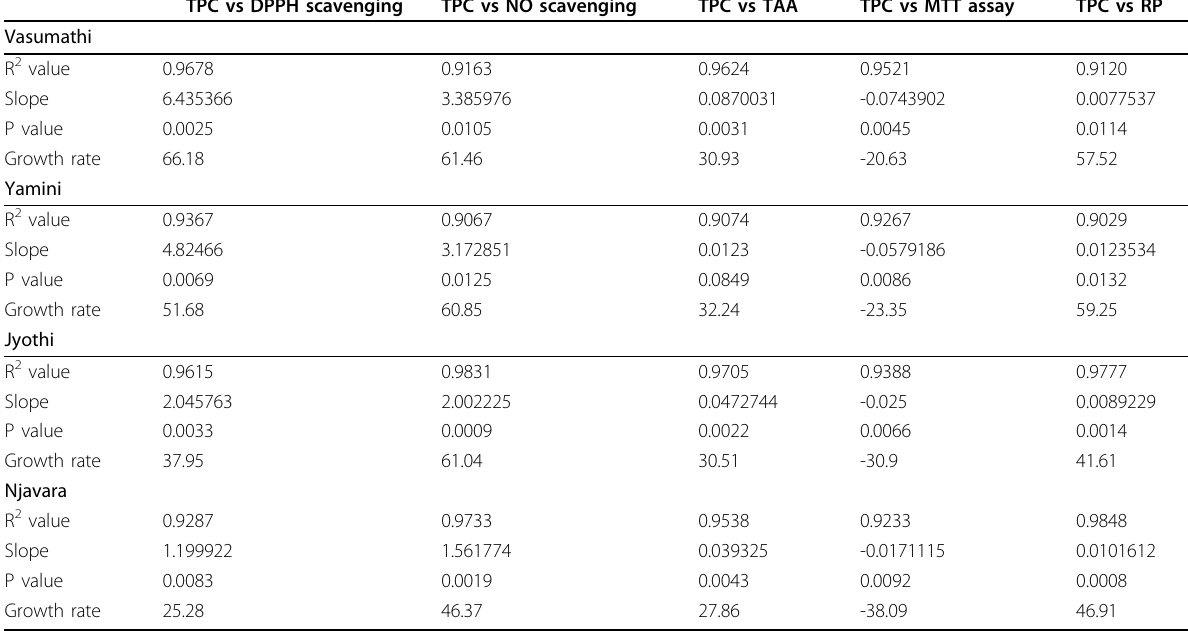
Table 3 Regression analysis of polyphenolic content from the methanolic bran extracts of different rice varieties with DPPH radical scavenging, Nitric oxide (NO) scavenging, Total Antioxidant Assay (TAA), MTT assay and Reducing Power